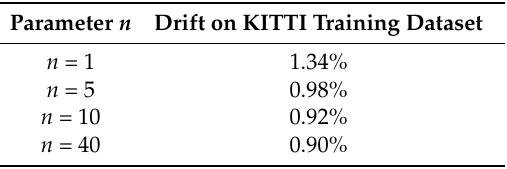
Figure 5. Variation of the number of non-ground planar features in different frames on sequence 01. Table 4. Importance of the Parameter n